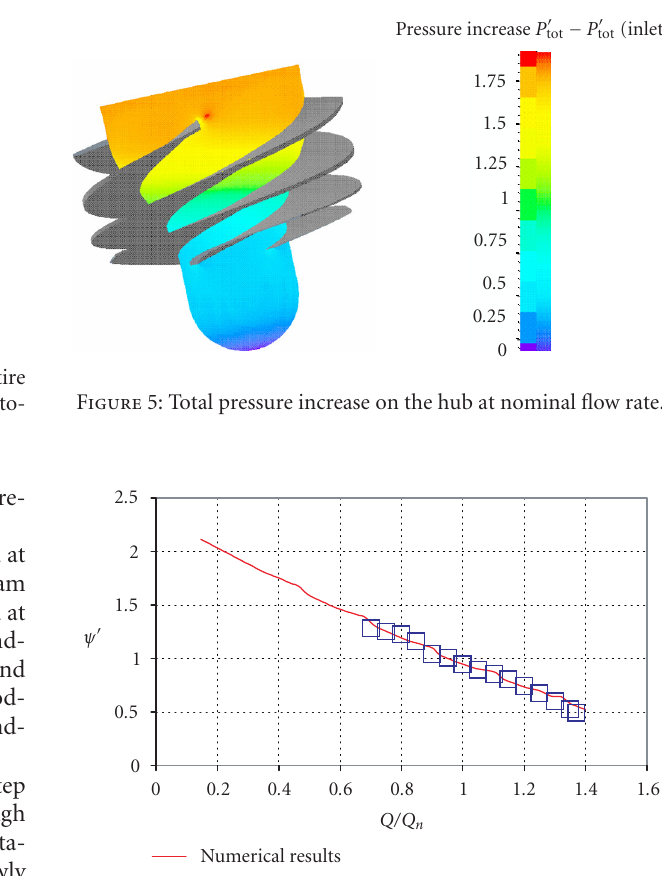
Figure 6: Characteristics ψ (cid:1)